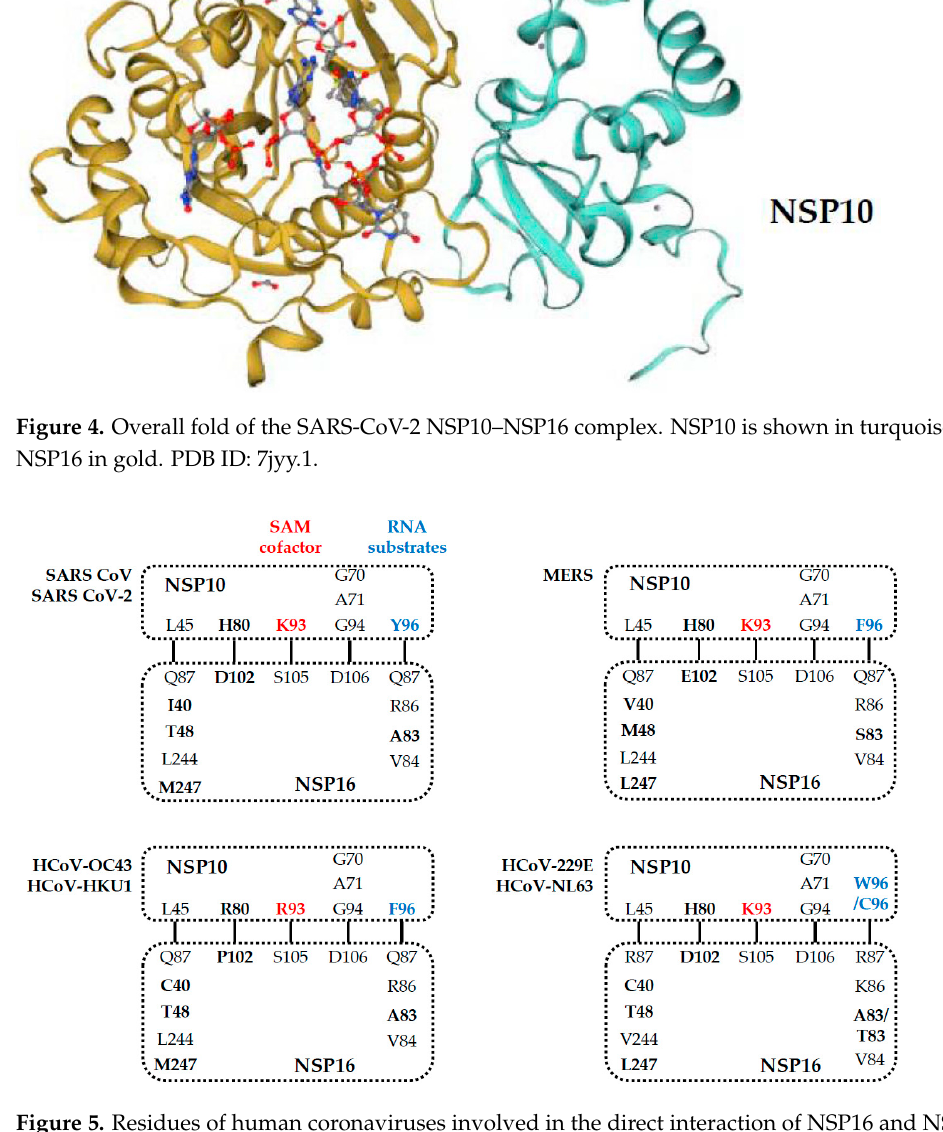
Figure 5. Residues of human coronaviruses involved in the direct interaction of NSP16 and NSP10.